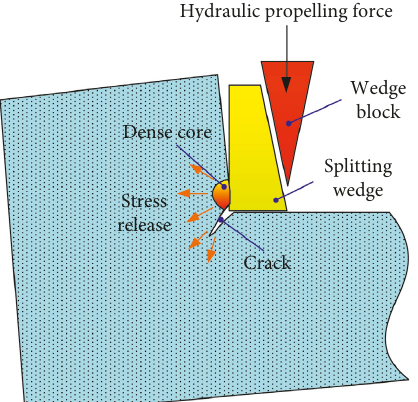
Figure 2: Microcosmic process of rock